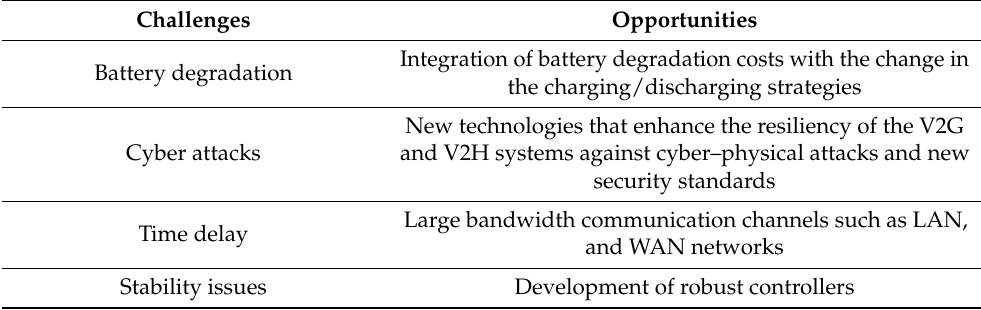
Table 3. Summary of challenges and opportunities of V2G and V2H for EVs [81]. Challenges Opportunities Integration of battery degradation costs with the change in Battery degradation the charging/discharging strategies New technologies that enhance the resiliency of the V2G Cyber attacks and V2H systems against cyber–physical attacks and new security standards Large bandwidth communication channels such as